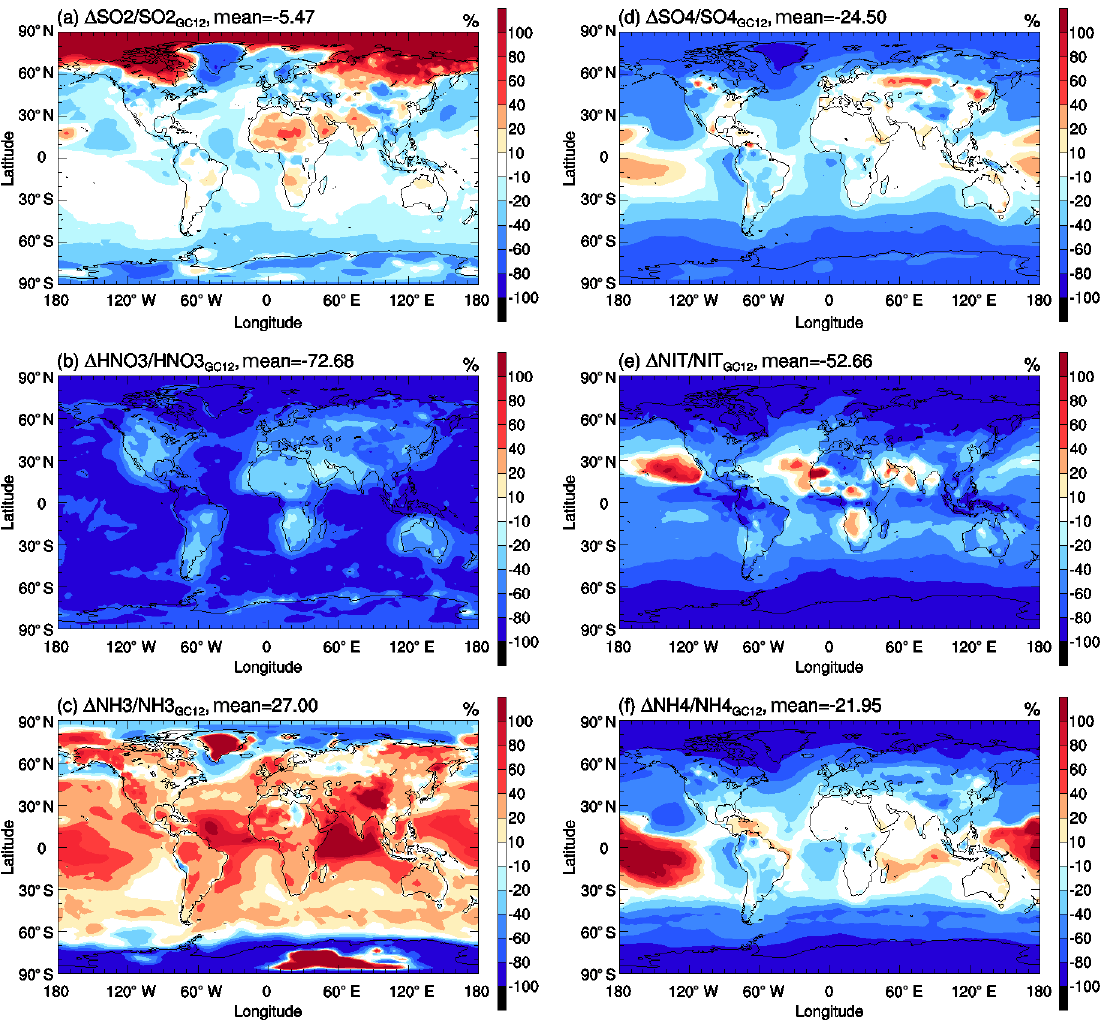
Figure 13. Horizontal distributions of percentage changes in annual mean (a) SO 2 , (b) nitric acid, (c) ammonia, (d) sulfate, (e) nitrate, and (f) ammonium surface mass concentrations due to the switching of GC12 case to WETrev